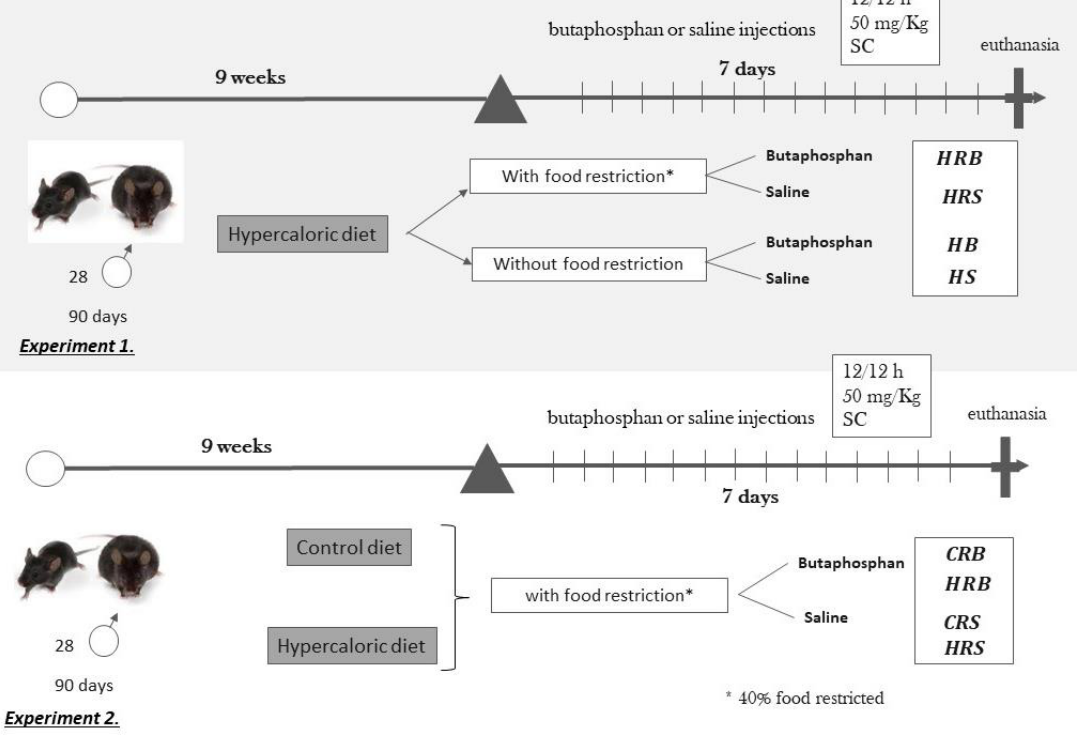
Figure 1. Experimental design. Experiment 1: all mice received hypercaloric diet ad libitum for 9 weeks and then, during the 10th week were randomized into four groups with or without food restriction and with butaphosphan or saline injections, each 12 h. Experiment 2: mice were initially randomized to hypercaloric or control diet for 9 weeks, and during the 10th week, all of them were submitted to food restriction and were treated with butaphosphan or saline injections each 12 h.